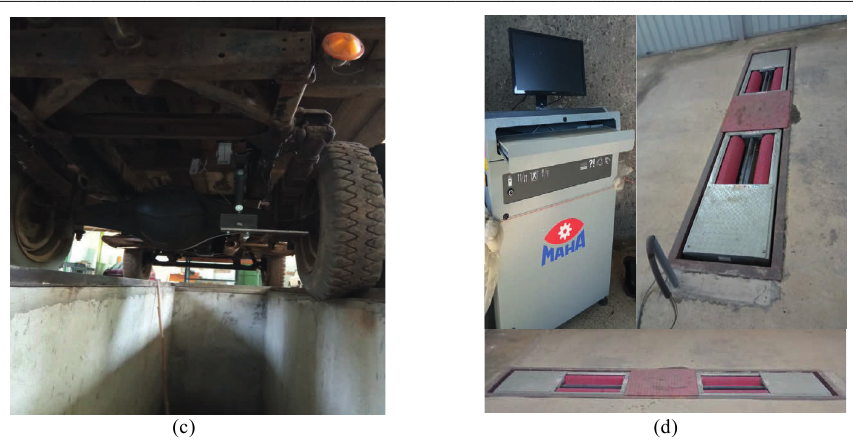
Fig. 12. Preparation of vehicle with a recuperative suspension for laboratory testing on the